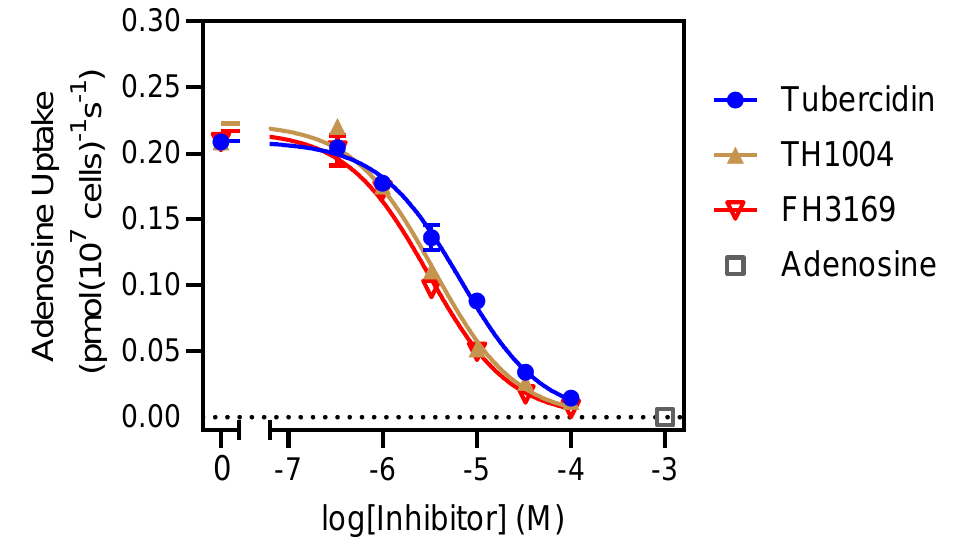
Figure 2. Uptake of 50 nM [ 3 H]-adenosine by LmexNT1.1 expressed in L. mexicana promastigotes from which both original alleles of LmexNT1.1/NT1.2 and of LmexNT2 had been deleted by CRISPR/cas9. Incubation time was 10 s, well within the linear phase of uptake [30]. Symbols represent averages of triplicate determinations, and error bars indicate ± SEM when not shown error bars fall within the symbol. The graph shown is a single experiment in triplicate, representative of three identical, independent